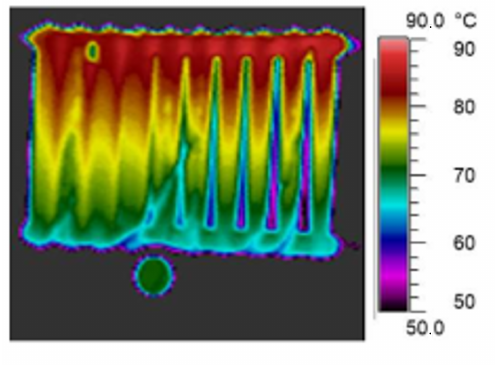
Figure 15. Radiator T1 surface temperature distribution according thermography measurements , mea- surements 1 , flow q mx = 0.0307 kg/s ( q max )— 356% nominal value .